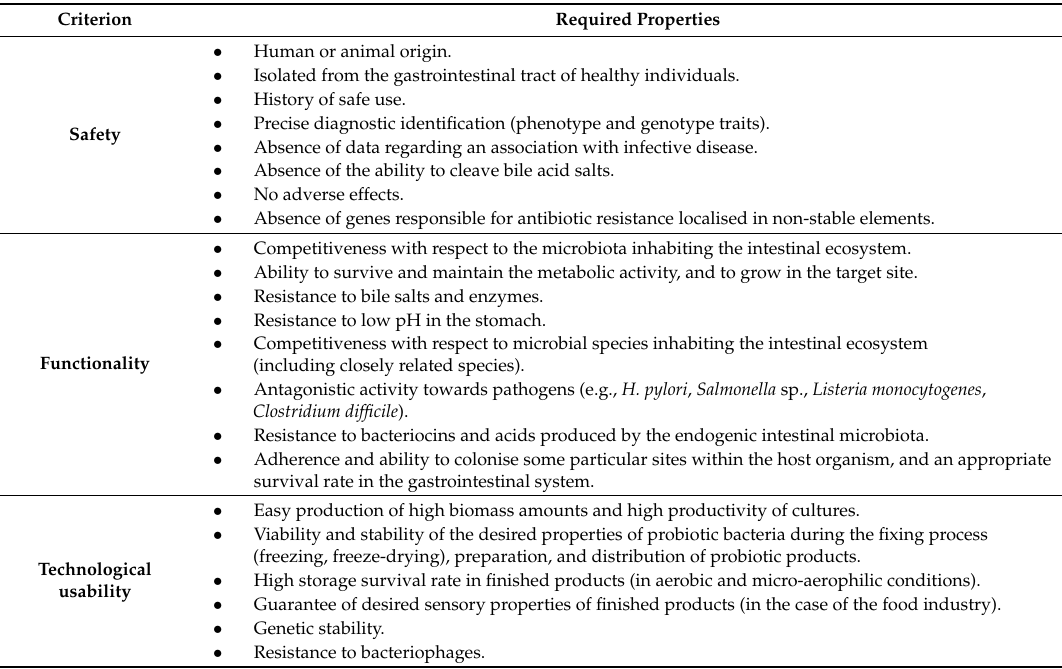
Table 1. Selection criteria of probiotic strains